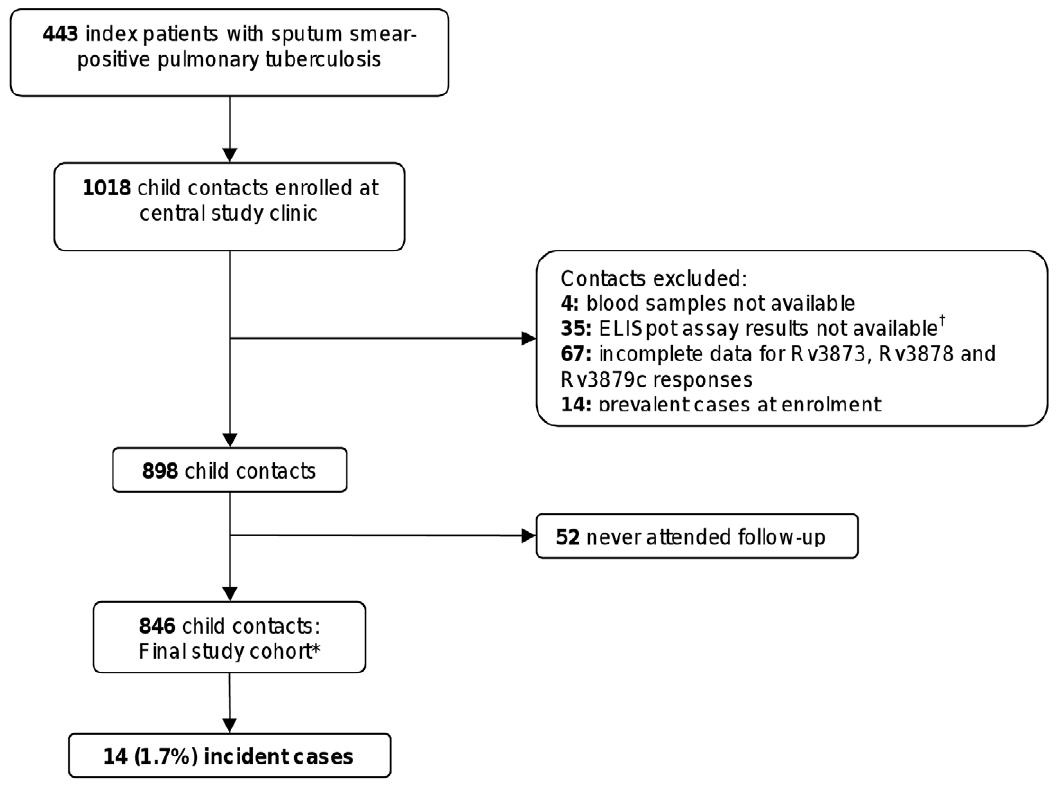
Figure 1. Study flow diagram. * The final study cohort of 846 child contacts with complete data on responses to all tested antigens was followed for 1125 person-years (mean duration: 1.04 years follow-up [range 0.25 to 3.28 years]). Fifty-seven children were lost to further follow-up after clinical assessment at six months; 256 children completed 24 months follow-up with six-monthly clinical reviews and 519 children were followed every six months by standardized health status telephone questionnaire administered to parents and guardians by the study nurse after the first 12 months of six-monthly clinical reviews. { Two contacts were removed due to loss of the ELISpot plates and thirty-three contacts were removed due to an episode of bacterial contamination of peptide pool reagents [38].